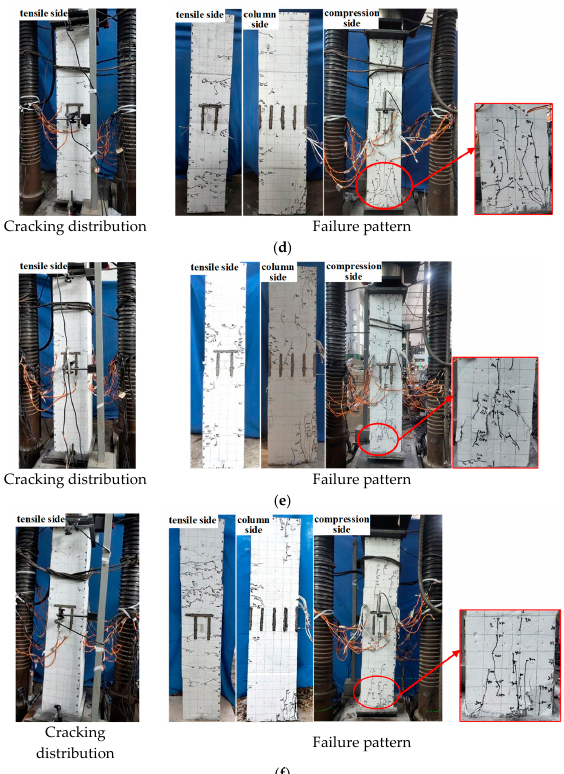
Figure 10. Cracks and failure modes of tested specimens. ( a ) Failure mode of unreinforced column; ( b ) Cracks and failure mode of specimen SCE-0.22(ECC-reinforced column); ( c ) Cracks and failure mode of column SCH3-0.15 (steel wire mesh-ECC-reinforced column); ( d ) Cracks and failure mode of column SCH3-0.22 (steel wire mesh-ECC-reinforced column); ( e ) Cracks and failure mode of column SCH5-0.22 (steel wire mesh-ECC-reinforced column); ( f ) Cracks and failure mode of column SCH3-0.27 (steel wire mesh-ECC-reinforced column). 4.3. Strain of ECC/Concrete and Rebars Based on the test data, the load-strain curves of the concrete of the unreinforced column and the ECC of the reinforced column were drawn and compared, as shown in Figure 11. When the load was small, the concrete strain of the unreinforced column and the ECC strain of the reinforced column was also small, which was in the elastic stage (OA stage in Figure 9a), and the strain increases approximately proportionally with the